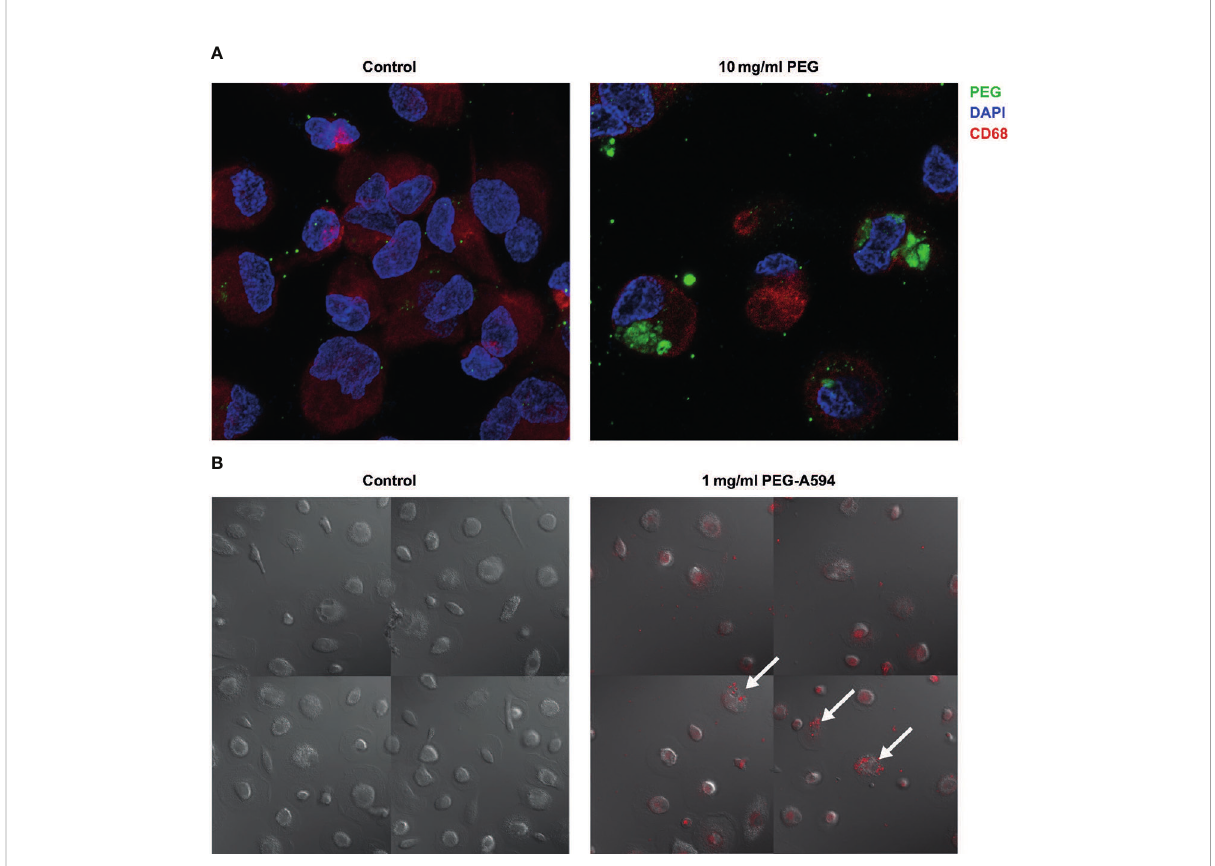
FIGURE 2 Uptake of 20-kDa PEG in human MDMs. (A) Representative confocal images of control MDMs and those exposed to PEG for 24 hours (n = 3). (B) Final images from live-cell imaging of MDMs from a single donor (30 hours after addition of PEG-A594). Arrows highlight representative MDMs with localization of PEG-A594 (red) in cytoplasm. DAPI, 4 ’ ,6-diamidino-2-phenylindole; MDM, monocyte-derived macrophage; PEG, polyethylene glycol.